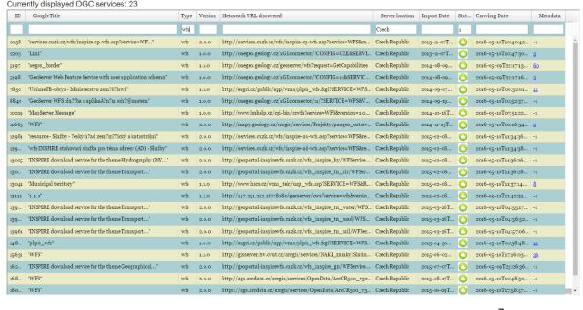
Figure 7. GUI of HTML List of OGC Services 7 .